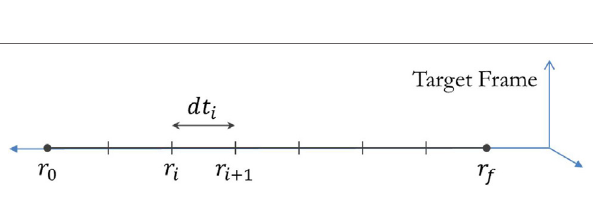
FigUre 4 | Schematic showing that the optimization process occurs over the time taken between radial steps along the synchronous terminal